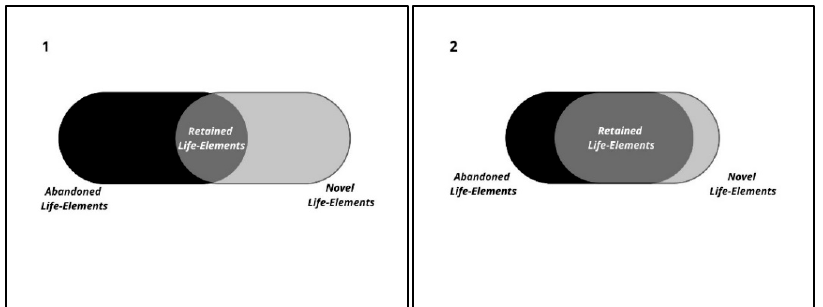
Figure 1. Transition—life elements are replaced, e.g., immigration ( Panel 1 ). Transition—life elements are omitted/excluded, e.g., the COVID-19 pandemic ( Panel 2